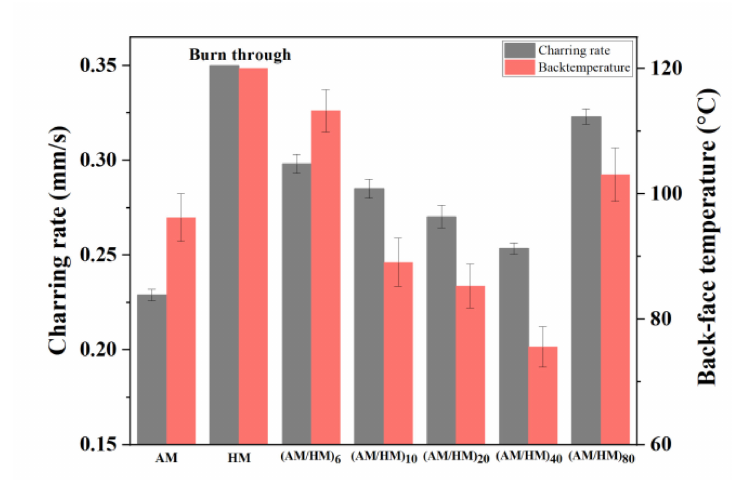
Figure 12. The R c and back-temperature of the (AM/HM) n